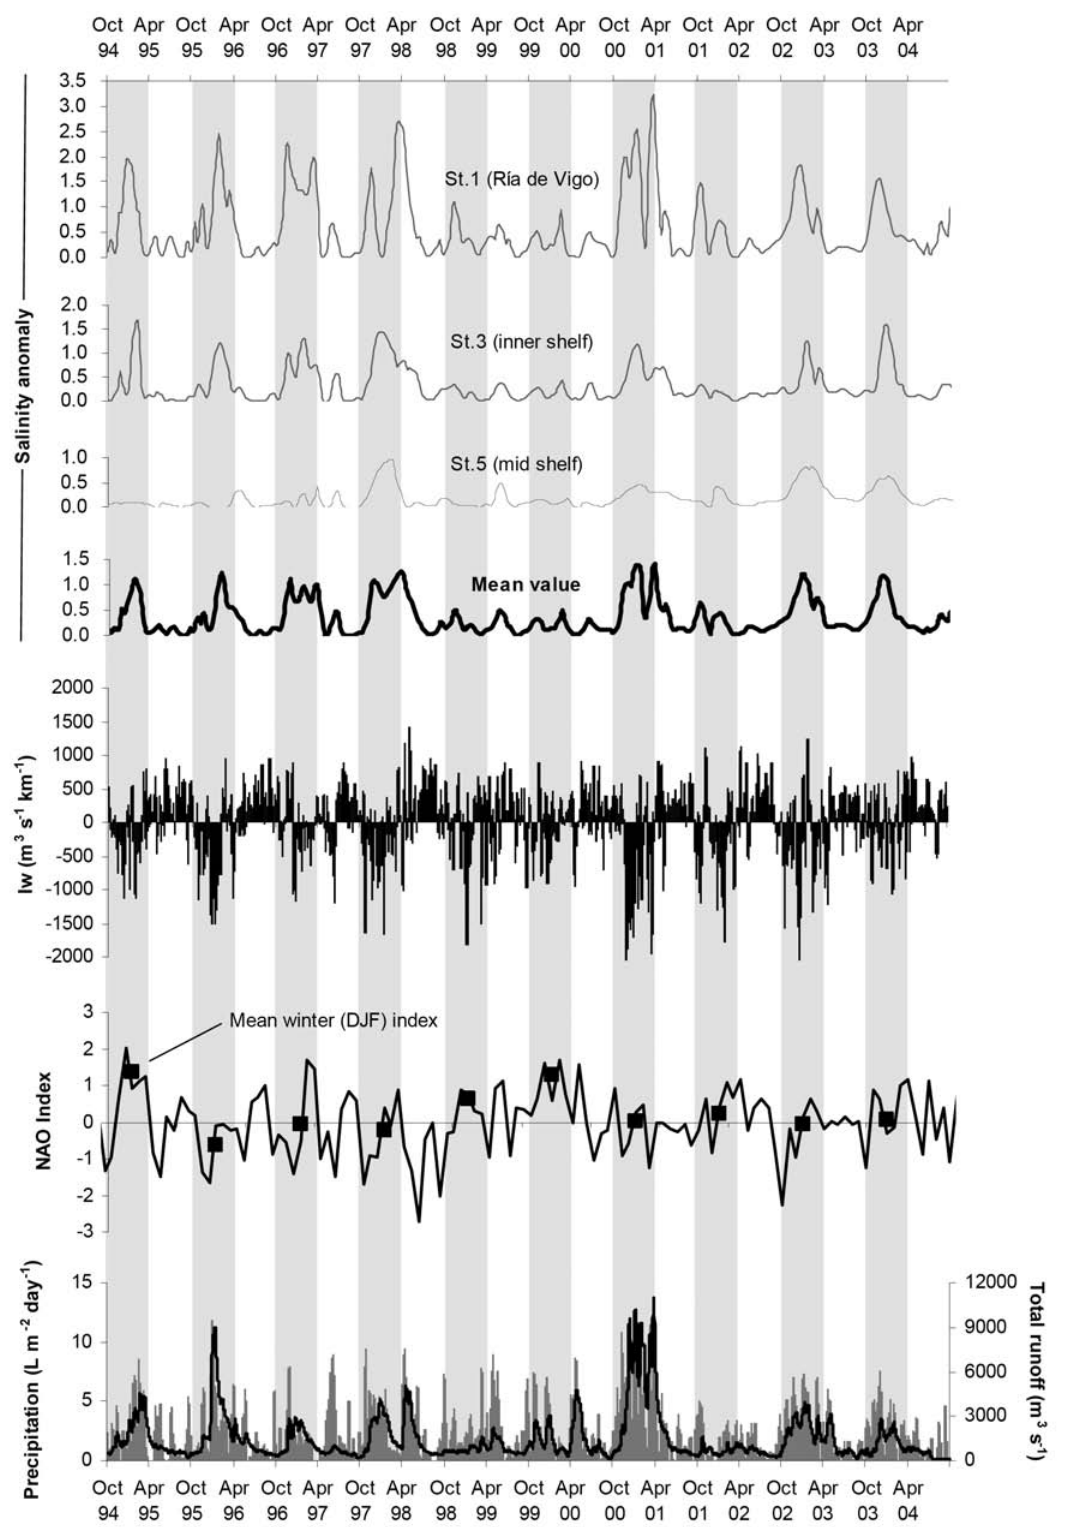
Fig . 13. – Integrated vertical salinity anomaly relative to 35.7 for stations 1, 3 and 5. An averaged value for these three stations is also plotted. The upwelling index ( Iw ; positive upwelling favorable), mean daily precipitation (gray bars) and the total mean daily river discharge estimated for the study region (solid line) are shown. Monthly values of the NAO index (solid line) are shown together with mean winter monthly values, which are the monthly mean of December, January and February (squares). Shaded regions separate the upwelling season (October to March) from the downwelling season (April to